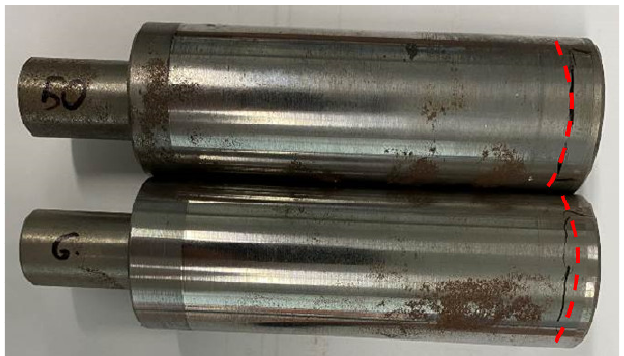
Figure 8. Samples No. 6 and No. 50 (red lines indicate the places where the samples were cut).